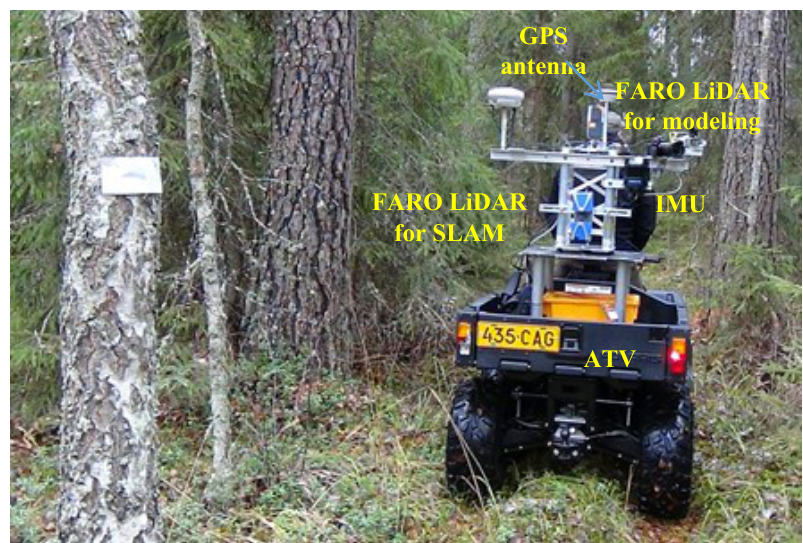
Figure 1. ATV with mounted devices including GNSS antennas and receivers, IMU and LiDAR.